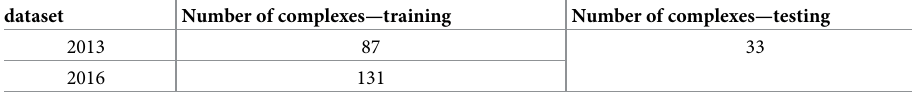
Table 4. Summary of the 2013 and 2016